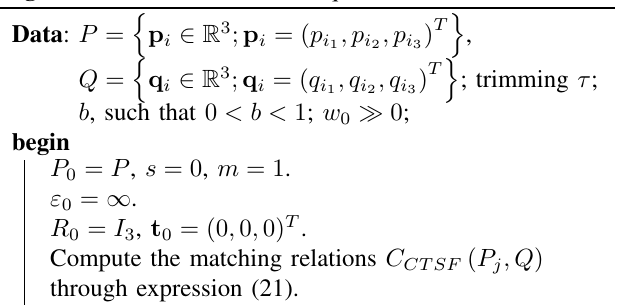
Algorithm 3: SWC-ICP